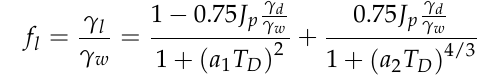
where γ l is the bulk density of liquid water (kg · m − 3 ); γ w is the bulk density of the combine liquid water and ice constituents (kg · m − 3 ); J p is the plasticity index; γ d is the soil density (kg · m − 3 ); a 1 and a 2 are defined as 0.2/ the depression temperature (K), defined as 273.15– T , and T is the node temperature (K). γ l and γ w are further specified in the SNTHERM model: